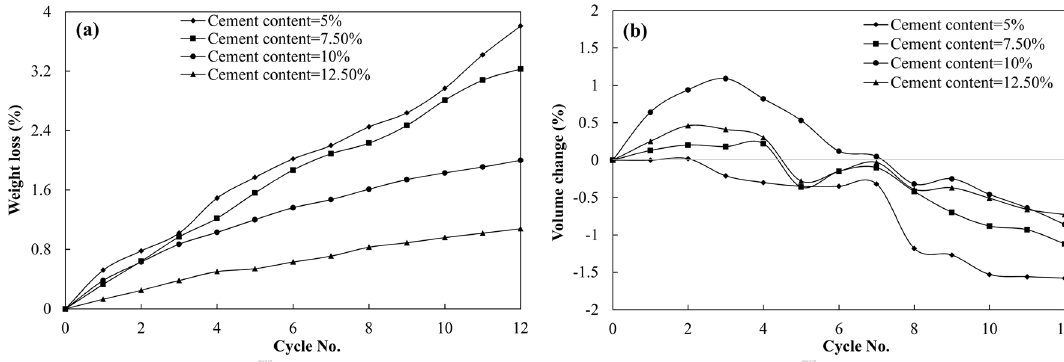
Fig. 12 The weight loss ( a ) and volume loss ( b ) of CSG mixtures after freezing–thawing